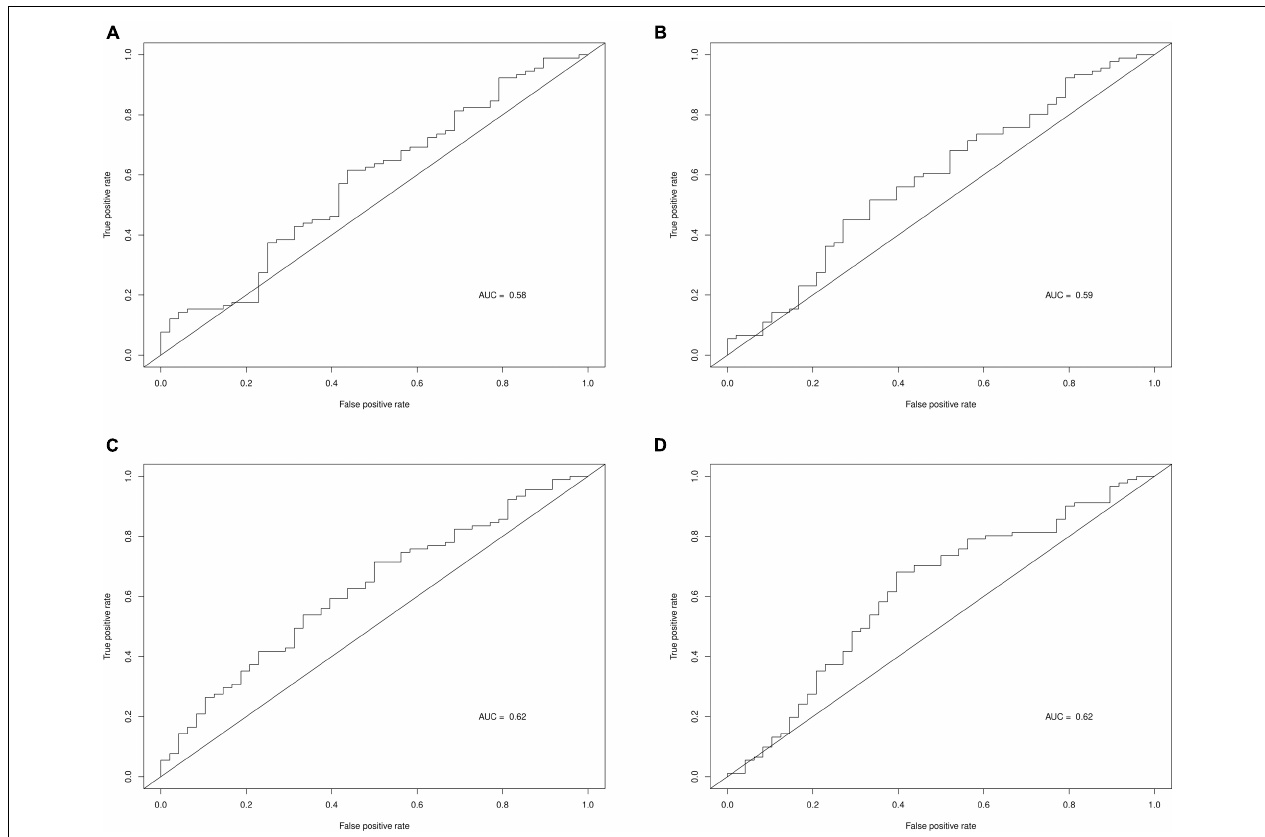
FIGURE 3 | ROC curves and AUC for each prediction model. (A) Clinically selected prediction model 1. (B) Clinically selected prediction model 2. (C) Data driven prediction model 1. (D) Data driven prediction model